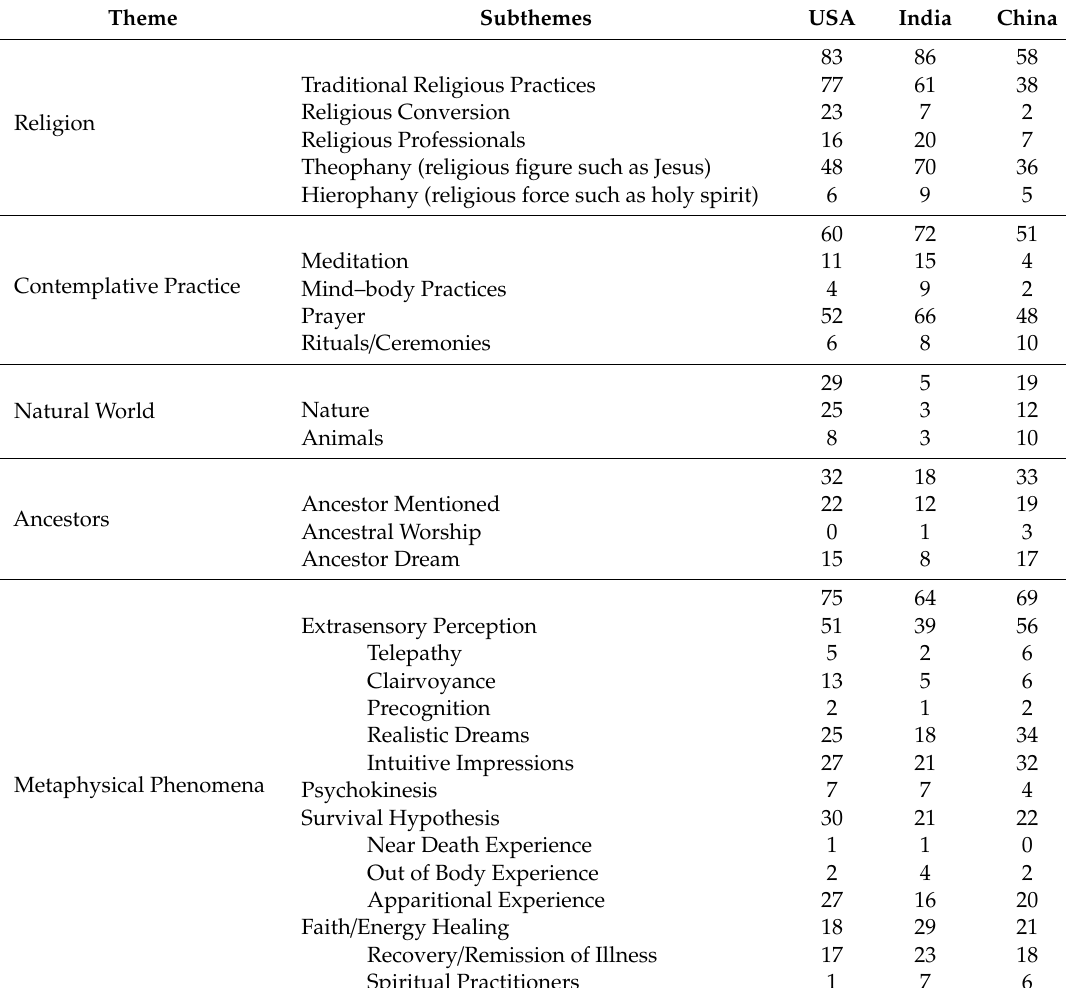
Table 2. Rates of Codes Occurrence by Country